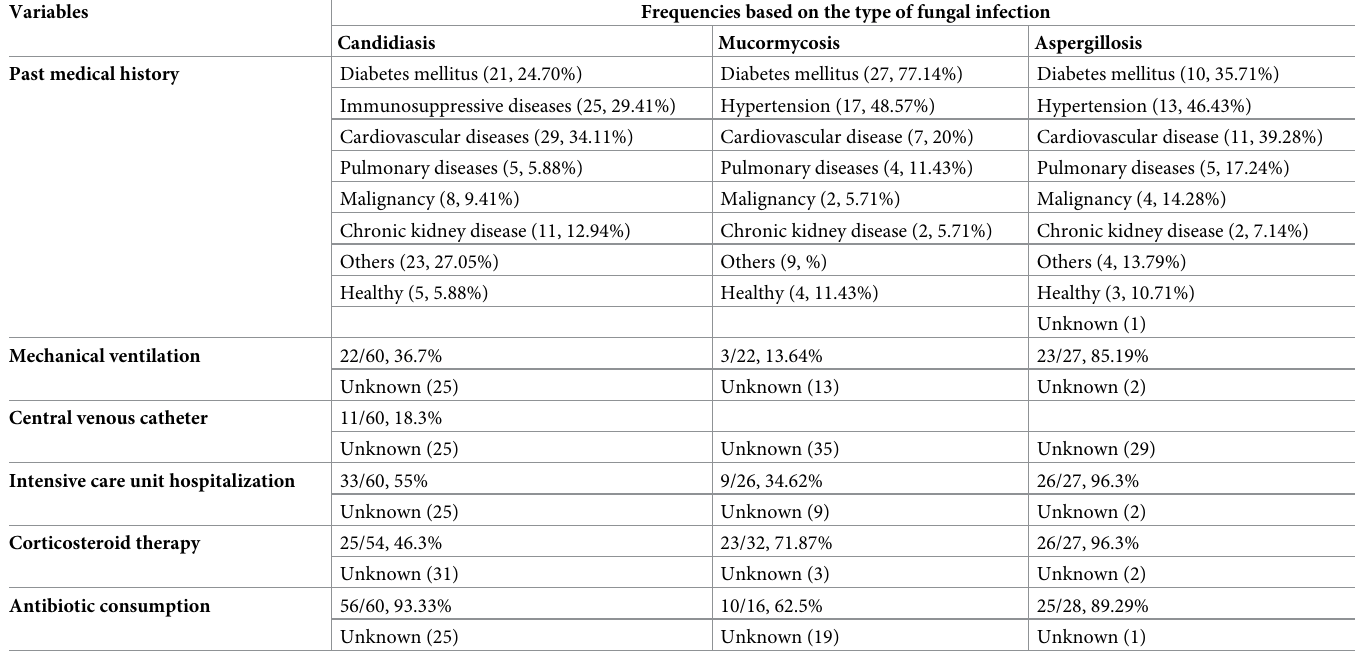
Table 2. Frequency of comorbidities and risk factors in COVID-19-associated fungal infection cases reported from Iran up to November 5, 2021.